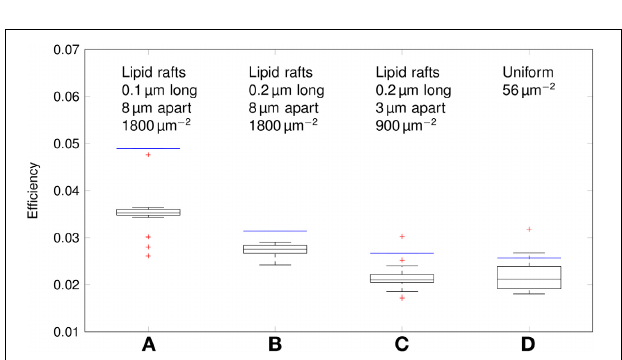
FIGURE 10 | Efficiency of action potentials for different channel distributions in a 0.1 µ m diameter C-fiber axon. Data was obtained using both deterministic (blue lines) and stochastic (boxes) simulations. (A) l = 0 . 1 µ m , L = 8 µ m, optimal values given by Zeng and Tang (2009), Na + channel density 1800 µ m − 2 , (B) l = 0 . 2 µ m , L = 8 µ m, Na + channel density 1800 µ m − 2 , (C) l = 0 . 2 µ m , L = 3 µ m, Na + channel density 900 µ m − 2 , based on data on lipid raft placement given by Pristerà et al. (2012) and personal communication with Amber Finn. (D) Uniform distribution. On each box, the central mark is the median, the edges of the box are the 25th and 75th percentiles, the whiskers extend to the most extreme data points not considered outliers, and outliers are plotted individually.